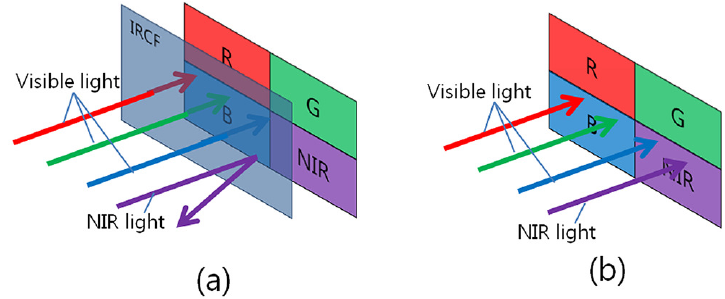
Figure 2. Infrared cut-off filter (IRCF): ( a ) typical imaging system using IRCF; ( b ) IRCF-removed imaging system.